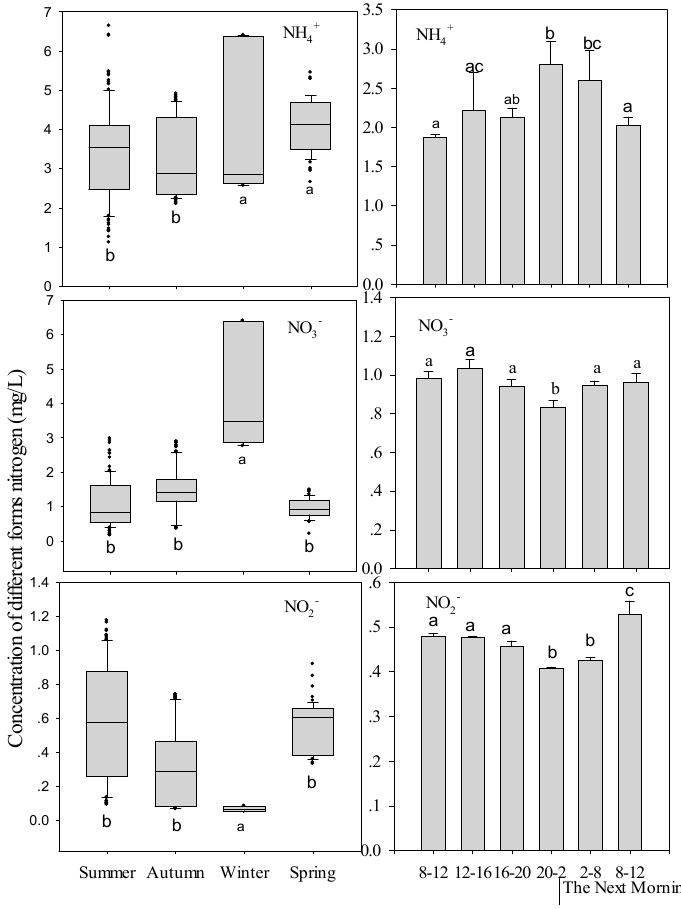
Figure 2. Concentration variation characteristics of different forms of nitrogen. The three plots in the left column are box plots; they represent concentration values of NH 4 + , NO 3 − and NO 2 − in different seasons, and the short line in the middle of every small box represents the middle value of the object data. The three plots in the right column are bar charts with mean concentration values (±SD) at different times of the diel cycle.